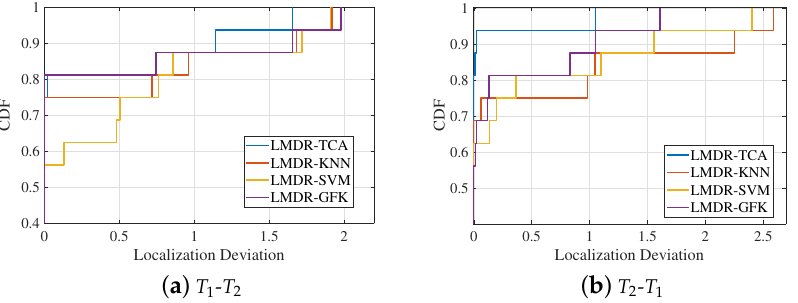
Figure 12. Cumulative distribution functions of localization errors: ( a ) training with the T 1 dataset and testing on the T 2 dataset; ( b ) training with the T 2 dataset and testing on the T 1